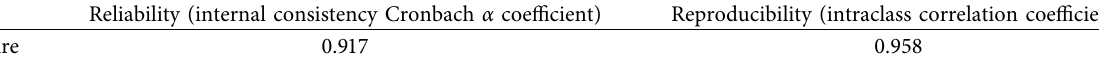
Figure 2: Repartition of the MIQ. Table 5: Reliability of the Moroccan Arabic version of the MIQ.